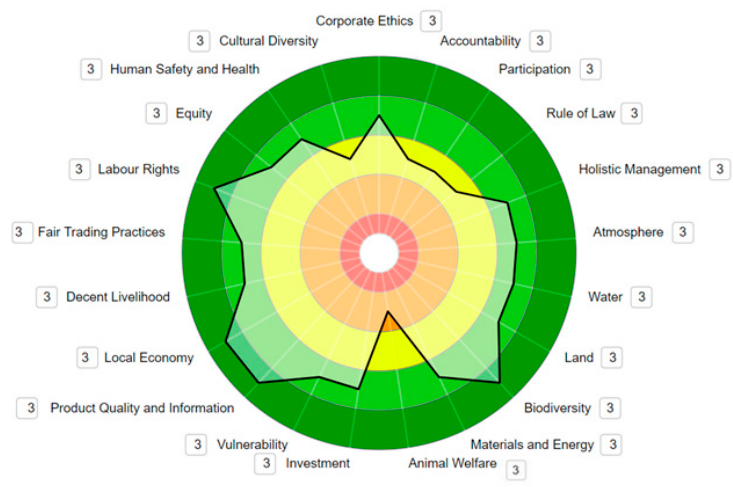
Figure 9. SAFA assessment result of the start ‐ up as spider graph. The number near indicators sug ‐ gest the data quality according to Table 4, and also, the colour in the circles represent the range score. As reported in Table 3, the colour means the performance score: Dark green: Best; light green: Good; yellow: Moderate; orange: Limited; red: Unacceptable. yellow: Moderate; orange: Limited; red: